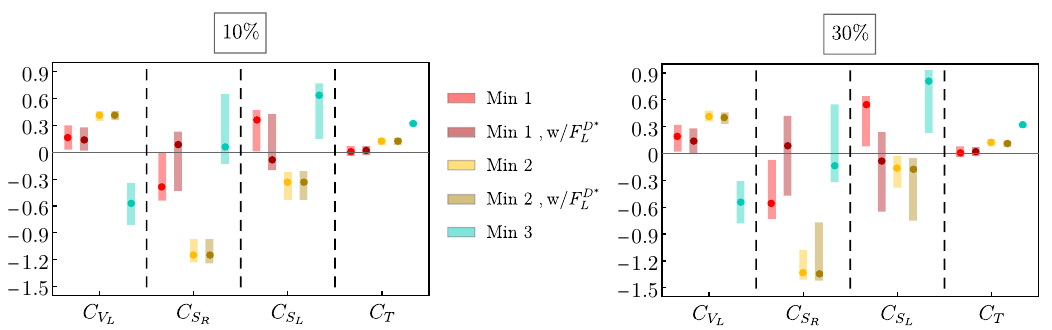
Figure 2 . Wilson coefficients for the minima obtained in the global fit with and without including polarization. On the left (right) panel, the F D ∗ L the explicit values.